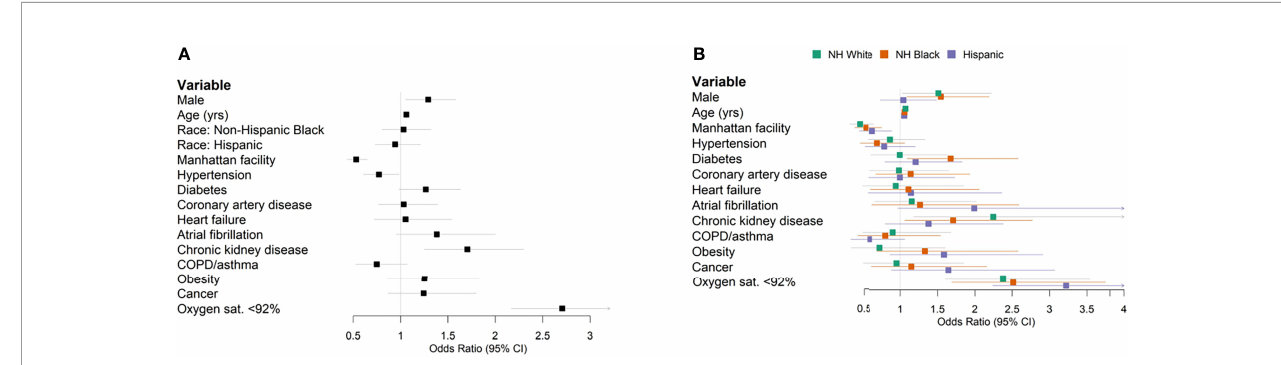
FIGURE 2 | Forest plots of multivariable logistic regression results predicting in-hospital mortality. (A) All patients. (B) Strati fi ed by